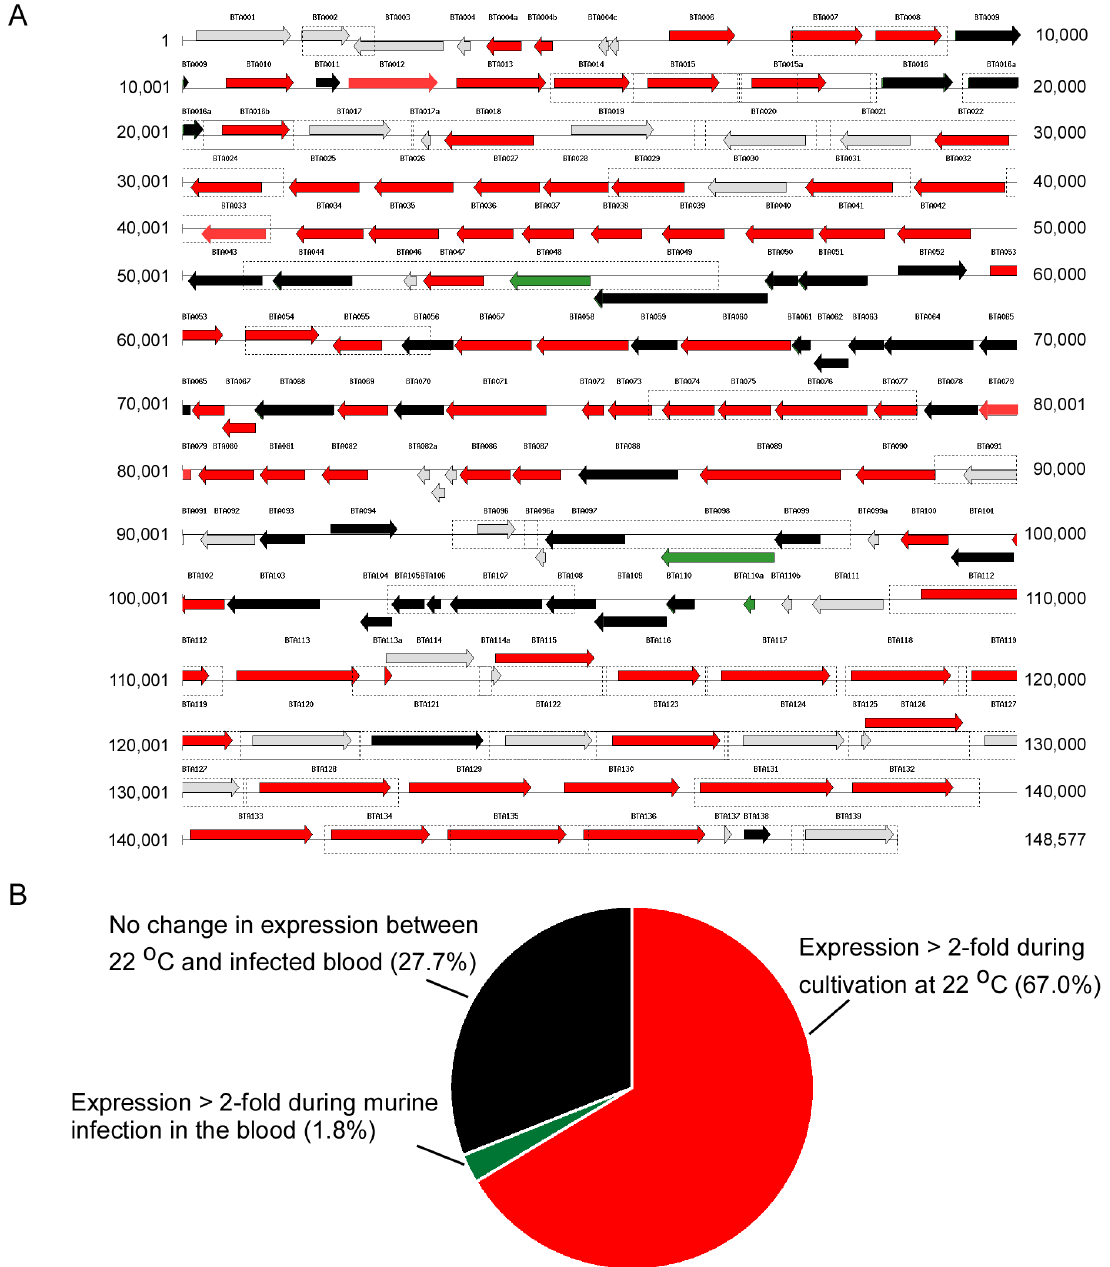
Fig 4. Transcriptional profile of lp150. Grey shaded arrows indicate ORFs that were not present on microarrays, while red and green indicate ORFs that were up-regulated at 22°C and the blood, respectively (A). Black arrows represent ORFs that were not differentially expressed under the two conditions or the transcript signal was below negative controls (A). The nucleotide number is displayed on the right and left of the image, while ORF designations are shown above the arrows. Also shown are the ratios of ORFs on lp150 that are up-regulated in the blood, 22°C, and those not differentially expressed